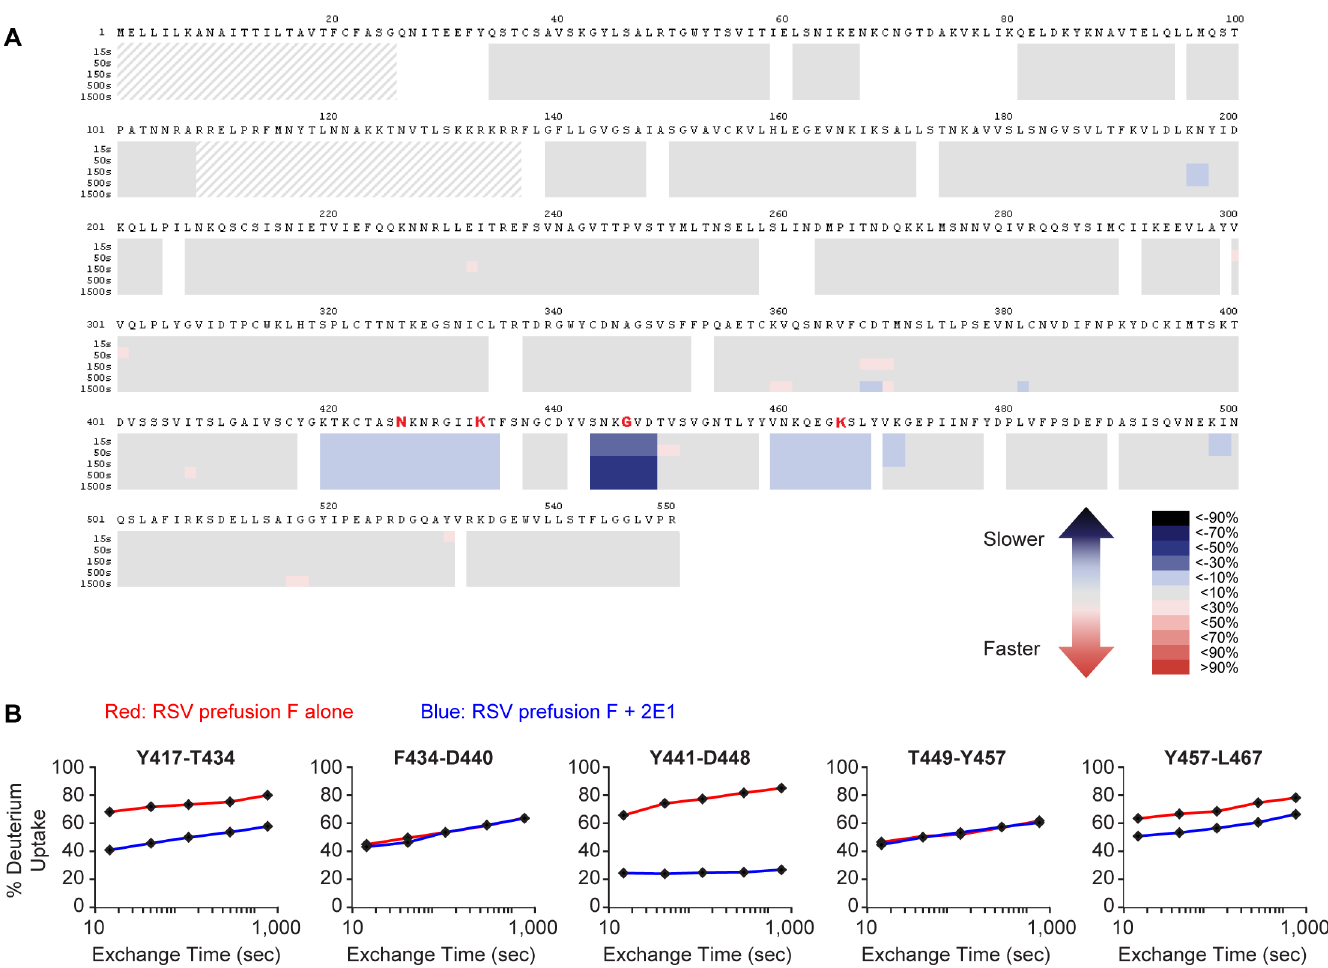
Fig 5. Epitope mapping of 2E1 by hydrogen/deuterium-exchange mass spectrometry. (A) Heat map plot showing the difference in deuteration levels of the RSV prefusion F protein alone compared to RSV prefusion F protein in the presence of the 2E1 monovalent Fab at five time points (15, 50, 150, 500, and 1500 sec). Slower deuterium exchange indicates regions containing the binding sites. White areas are ‘ gaps ’ for which there was no sequence coverage, and thus no HDX-MS information was obtained. Dashed greyed-out areas represent sequences of the signal and P27 peptides which are not present in the mature purified protein. (B) Uptake plots of several RSV F peptides spanning the conformational epitope region. Red curves show the deuteration levels of peptides of RSV F protein alone, while blue curves show the peptides of the RSV F / 2E1 complex. Peptides containing the residues of antibody epitope (417 – 434, 441 – 448, and 457 – 467) showed decreased deuteration level upon 2E1 binding. In contrast, peptides with no significant decrease in the deuteration level upon 2E1 exposure represent non-epitope sequences (435 – 440 and 449 – 457). The residues identified as critical for binding by shotgun mutagenesis are indicated in red